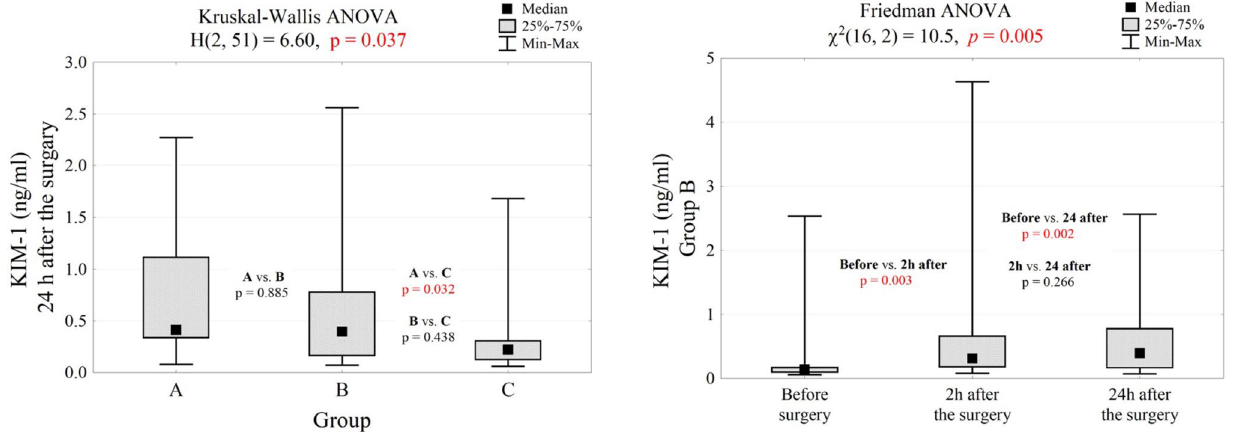
Figure 4. KIM-1 levels in groups A, B, and C measured 24 h after surgery, and in group B measured before and 2 h and 24 h after